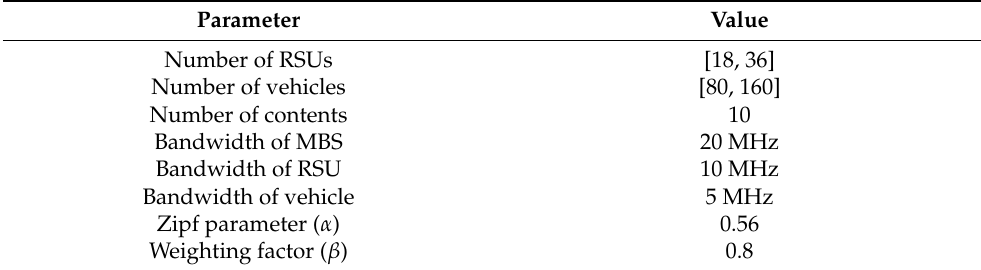
Table 1. Experiment